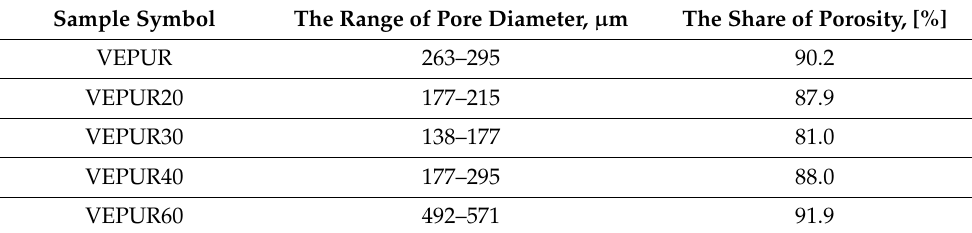
Figure 8. Results of pore size analysis of selected foams using tomographic analysis. Table 5. Summary of analysis results using micro-computed tomography (µCT).